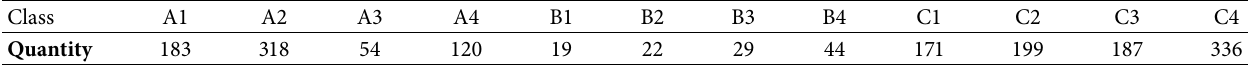
Table 1: Manual annotation frequencies of policy instruments.